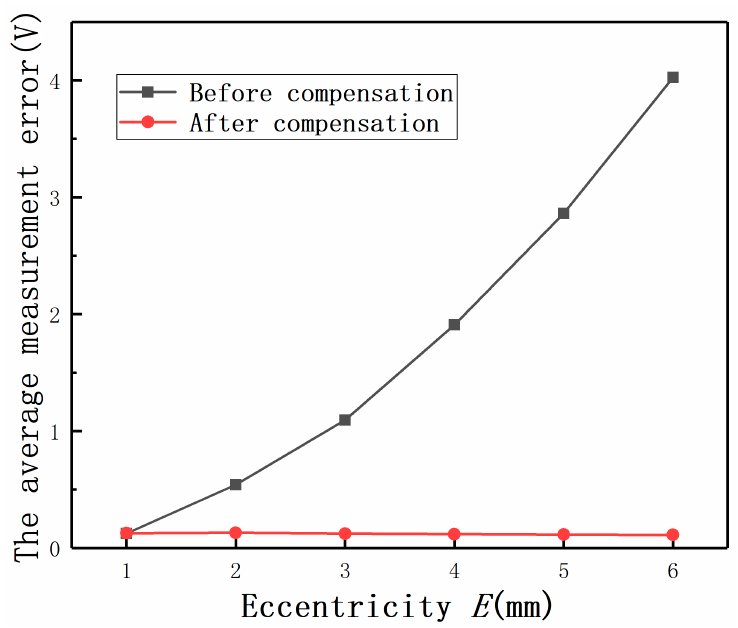
Figure 19. The average measurement errors before and after compensation.